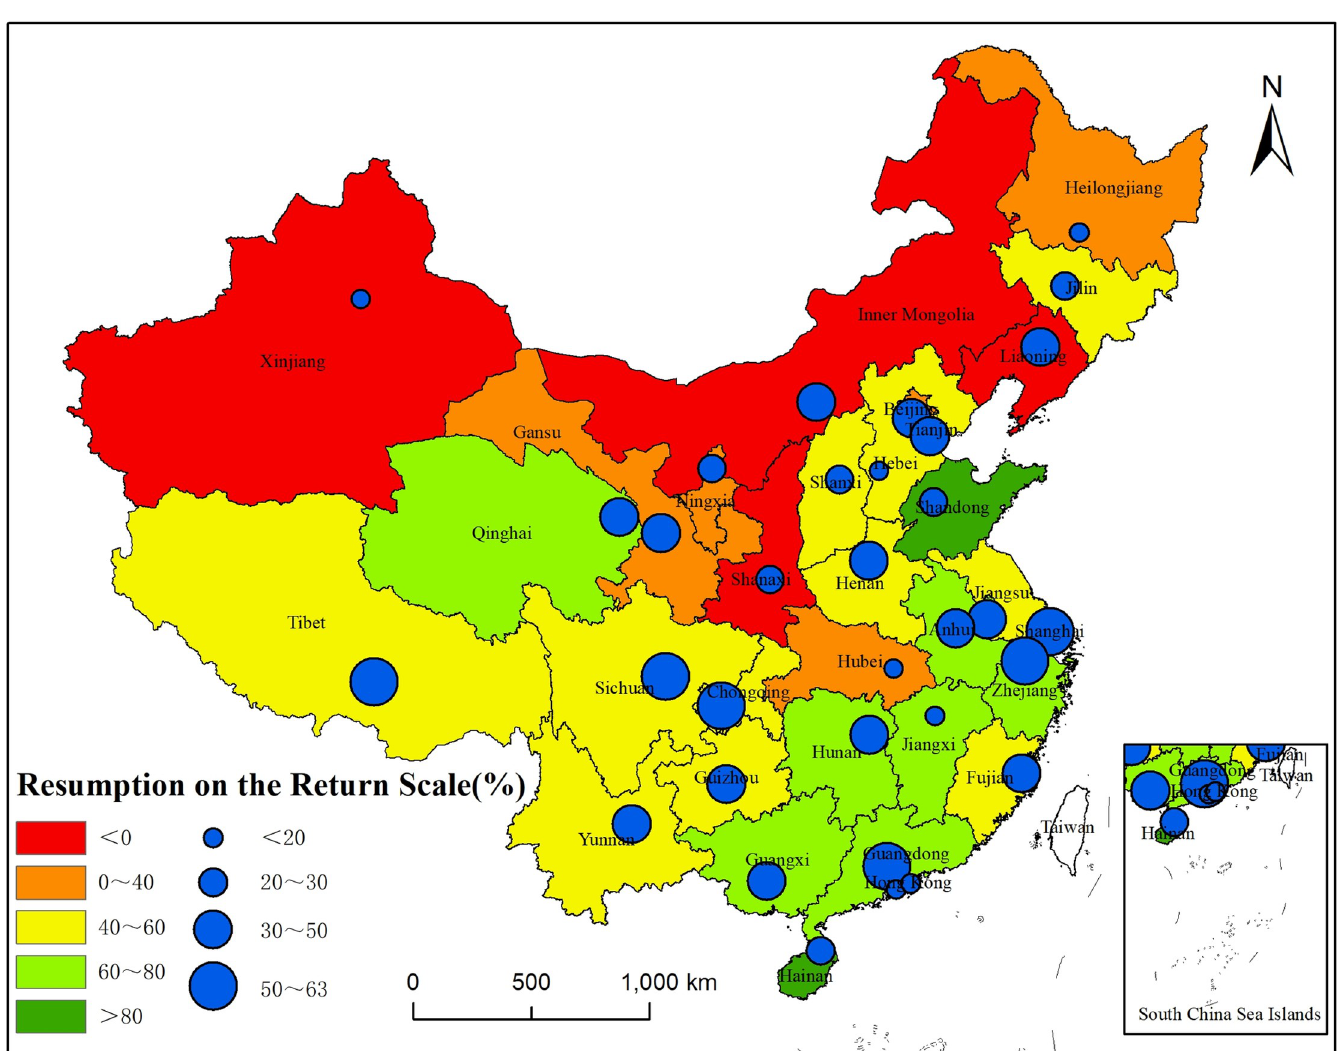
Fig 3. Distribution of the resumption of the scale of population return in provinces, municipalities and capital